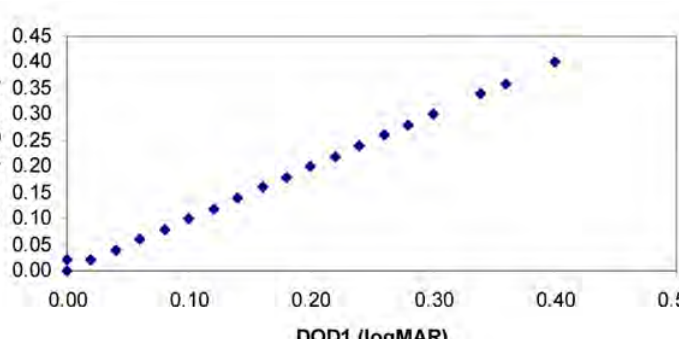
Figure 3. Showing the difference between the unaided VA and aided VA (method 1), plotted against the difference between un- aided VA and aided VA (method 2) for the right eyes (UAOD1- ADOD1 versus UAOD2 – ADOD2) or (DOD1 – DOD2). The graph shows a perfect positive correlation between the values.